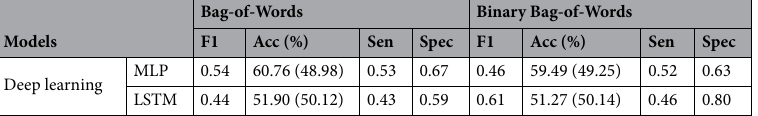
Table 6. Performance result obtained with deep learning LSTM and MLP applied to Bag-of-Words and Binary Bag-of-Words feature representation of the data.